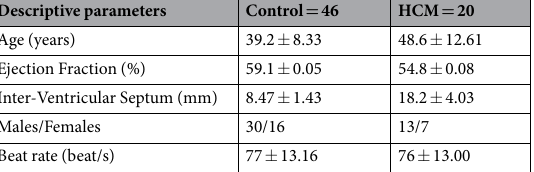
Table 2. Descriptive statistics ± standard deviation for the populations under